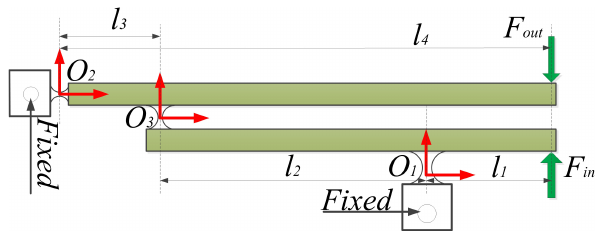
Figure 1. The two-stage amplifier.